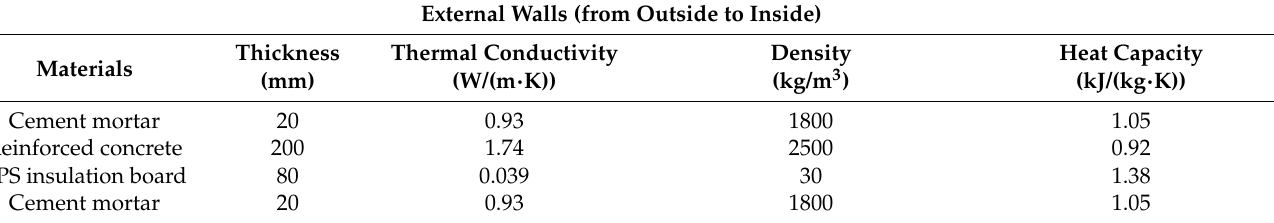
Table 2. The parameters of each